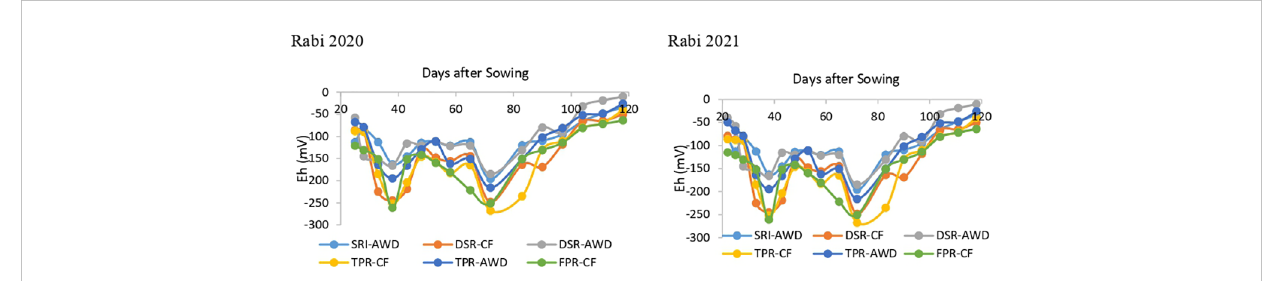
FIGURE 1 Effect of different rice production techniques on soil Eh (redox potential) in rice crop. SRI-AWD-T1; DSR-CF-T2; DSR-AWD-T3 TPR-CF-T4; TPR- AWD-T5;